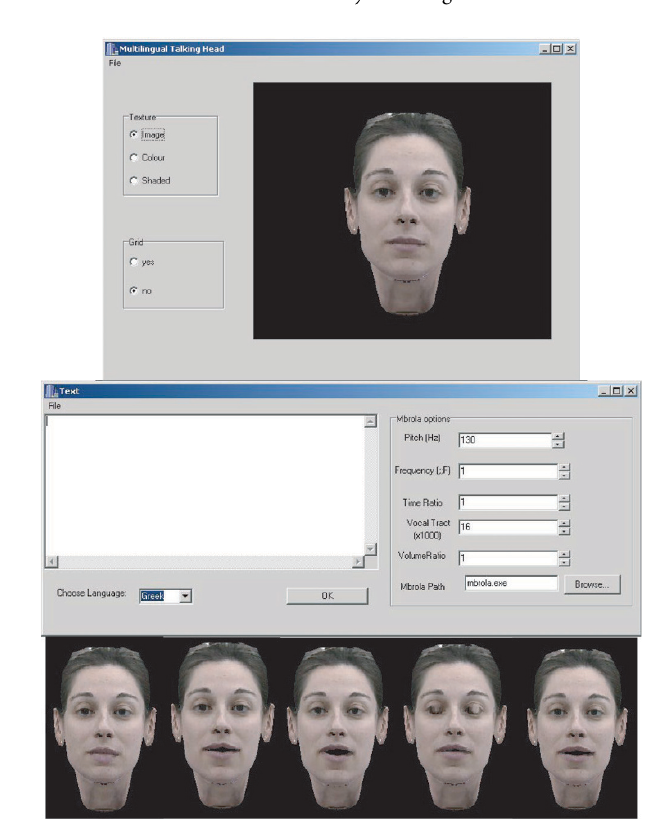
Figure 15: Venny test images.